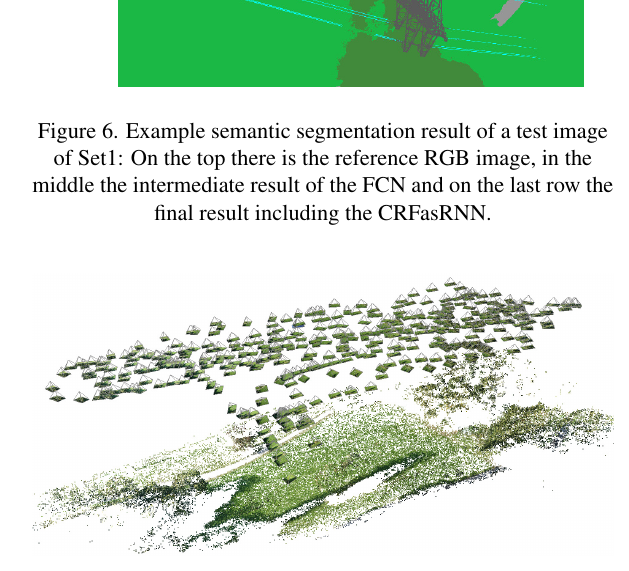
Figure 7. Sparse reconstruction result of Set1 showing the sparse point cloud and the camera